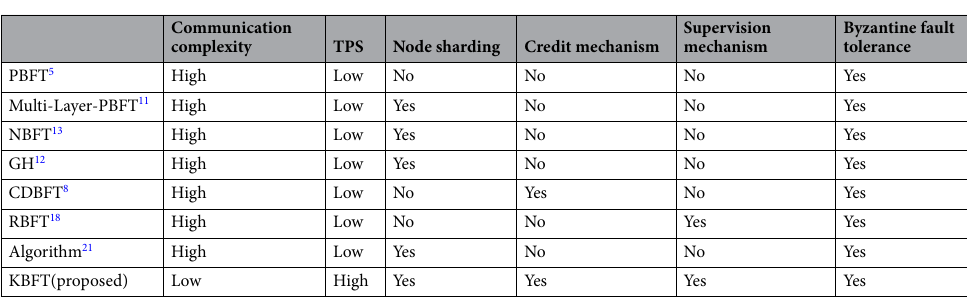
Table 1. Comparison of consensus